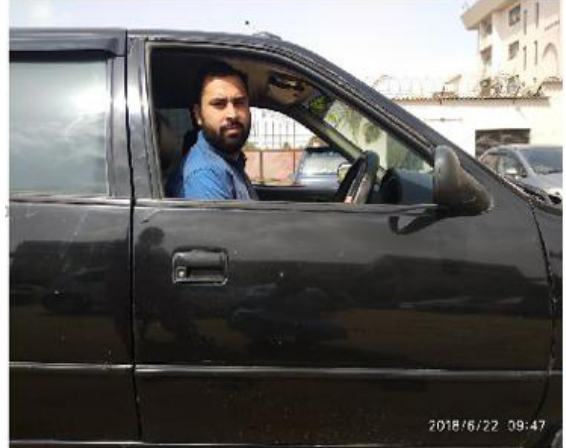
FIG.6. (b) EXTRACTED NUMBER PLATE IMAGE FROM